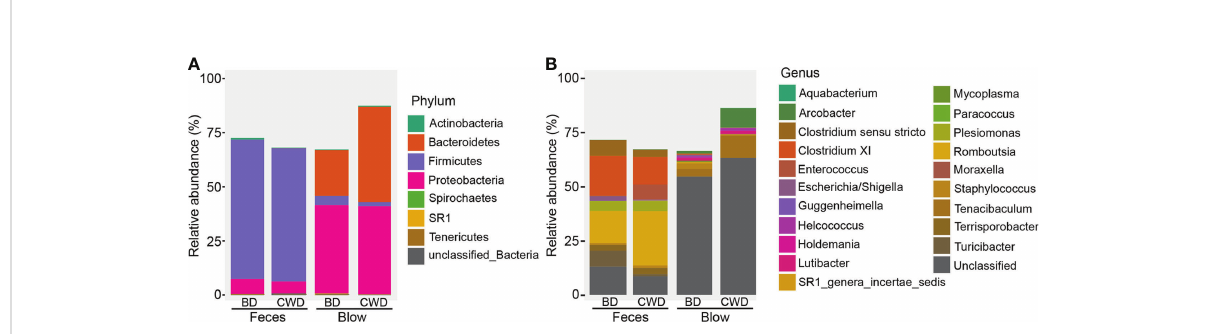
FIGURE 2 Taxonomic composition of 70 intra-cores detected from each dolphin. (A) , Phylum level. (B) , Genus level. BD indicates the bottlenose dolphin, and CWD indicates the Chinese white dolphin.